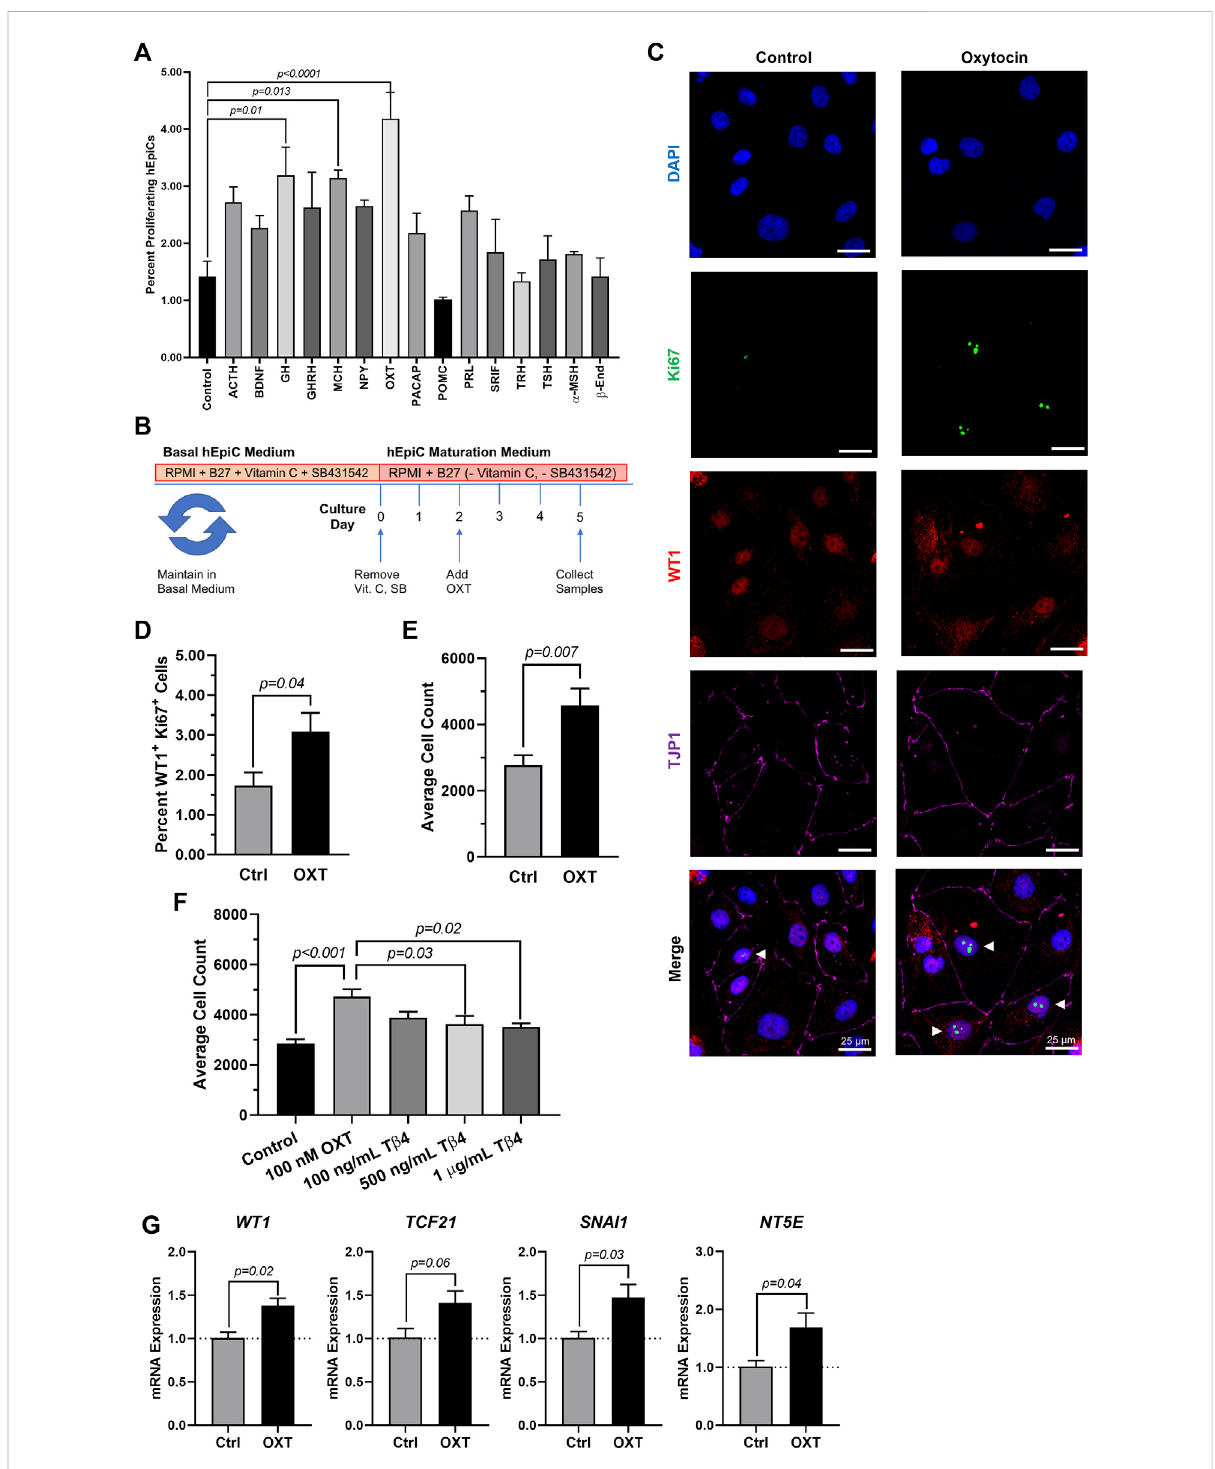
FIGURE 2 Oxytocin Induces Proliferation and Activation of hiPSC-Derived Epicardial Cells. (A) Screening results for 15 candidate neuroendocrine peptides, shown as the percentageof hEpiCs expressing H3P after exposure to each compound; n = 3 per condition. (B) Experimentaltimeline used to quantify OXT-induced epicardial activation. (C,D) Confocal immuno fl uorescent images (C) and quanti fi cation (D) of proliferating hEpiCs after 3 daysOXTexposure.In (C) ,epicardialcellsarelabeledwithWT1(red),epithelialmembranesarelabeledwithTJP1(magenta),proliferatingcells (arrowheads) are labeled with Ki67 (green), nuclei are labeled with DAPI(blue); n = 6imagesper condition, scale bar: 25 µm. (E,F) Absolutecounts of DAPI-labeledepicardialcellnucleiafter3 daysexposuretoOXT (E) orthymosin β 4 (F) ,acompoundpreviouslyshowntoinduceepicardialactivation; n ≥ 6 per condition. (G) qRT-PCR data for epicardial cells exposed to OXT, showing an increase in EpiPC ( WT1 , TCF21 ), EMT ( SNAI1 ), and mesenchymal ( NT5E ) markers; n = 4 per